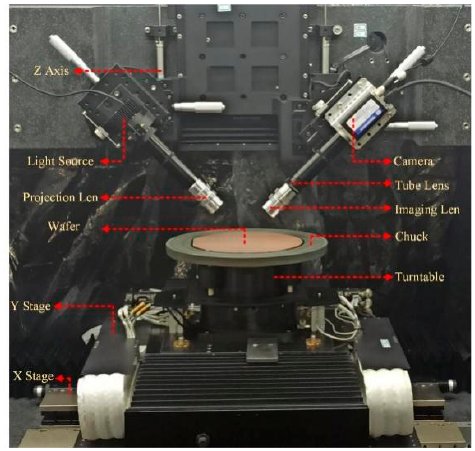
Figure 9. Photograph of the experimental setup.